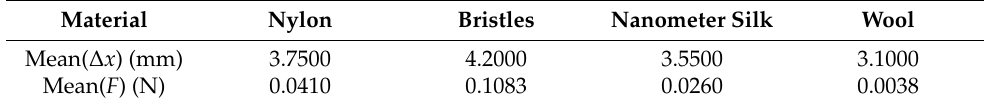
Table 3. The mean value of Δ x and F for brushes of different materials in Figure 8.